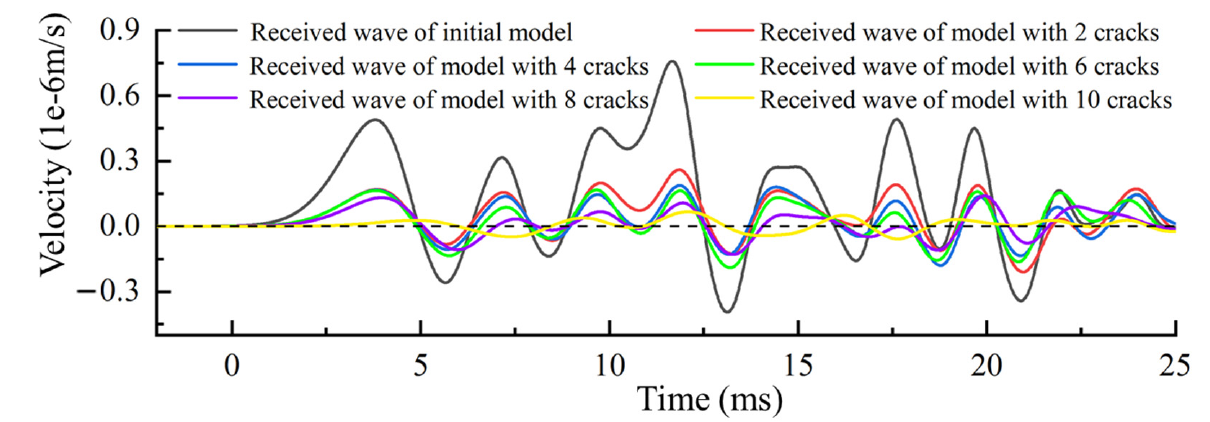
Figure 12. The first arrival wave before and after the change in the simulation. Table 1. The actual and calculated wave velocity change rate calculated with the first arrival wave. Medium with Medium with Medium with Medium with Medium 2 Cracks 4 Cracks 6 Cracks 8 Cracks